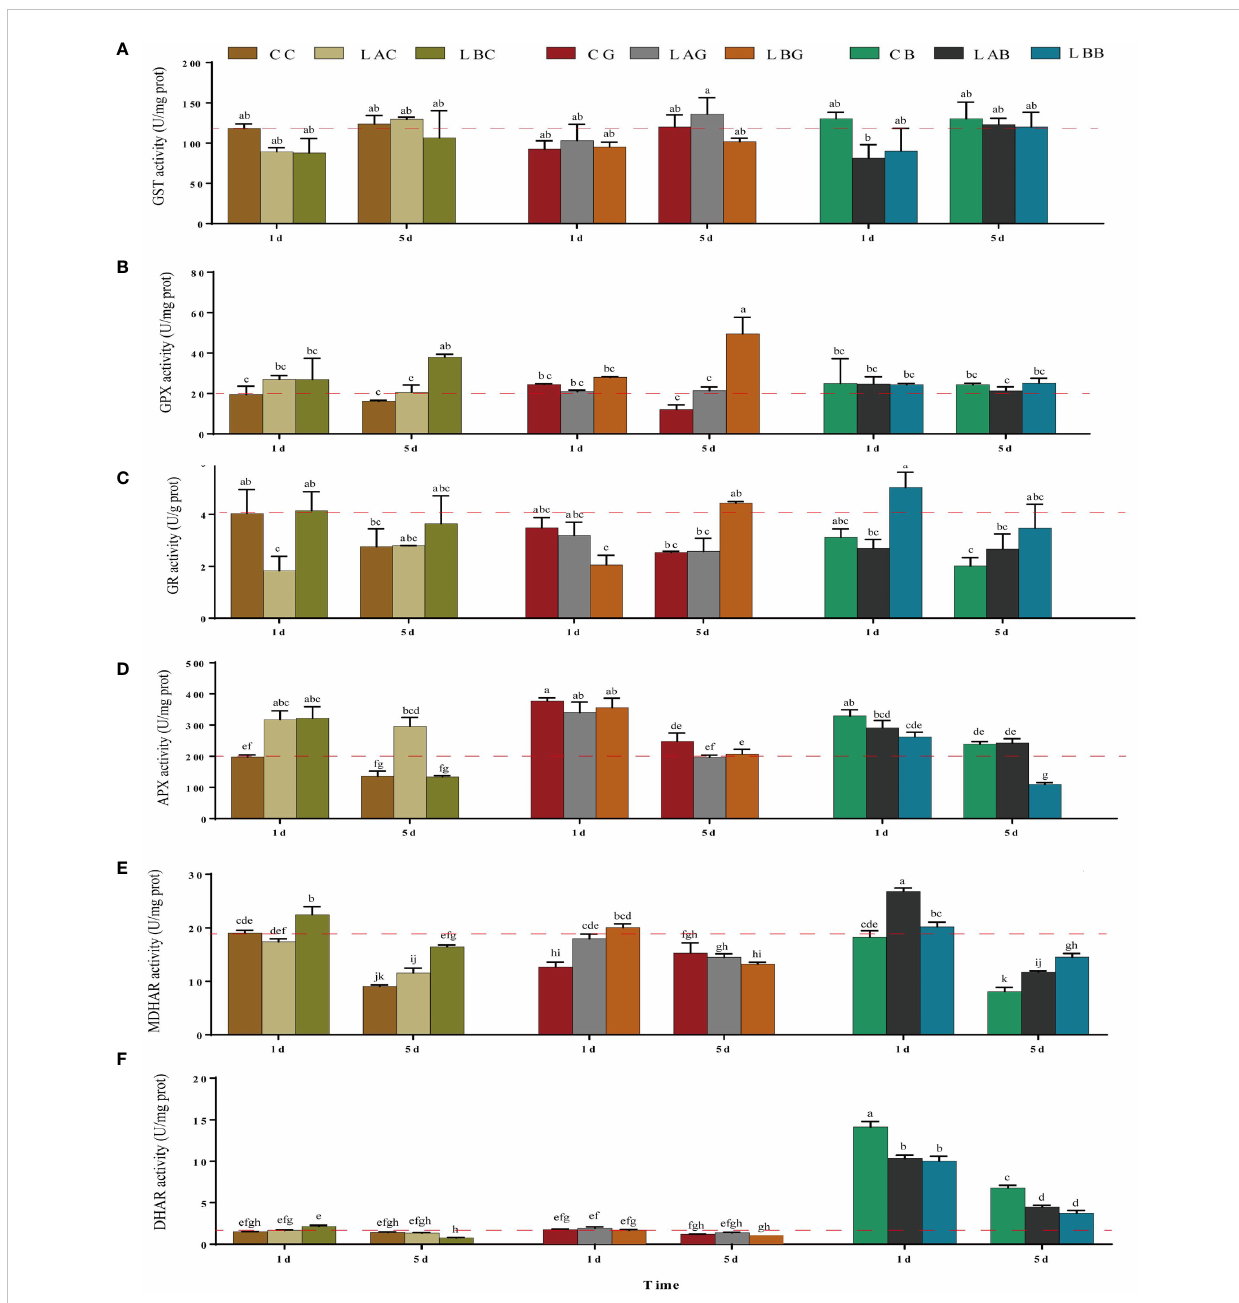
FIGURE 3 The (A) glutathione S-transferase (GST), (B) glutathione peroxidase (GPX), (C) glutathione reductase (GR), (D) ascorbate peroxidase (APX), (E) monodehydroascorbate reductase (MDHAR), and (F) dehydroascorbate reductase (DHAR) activity in B fuscopurpurea under different culture conditions. Data was Mean ± SD (n = 3). Different letters indicated signi fi cant differences ( p < 0.05). The red dotted line indicates the level in the CC (100% seawater)